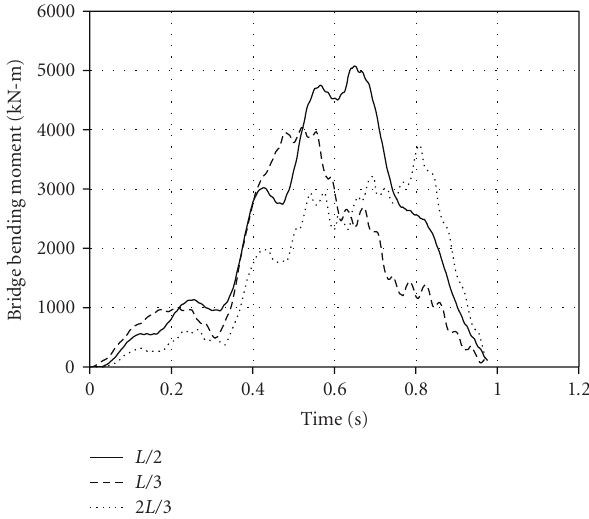
Figure 4: Typical bending moment histories of the bridge under a passage of the vehicle with a speed of 15 m/s and roughness surface of level